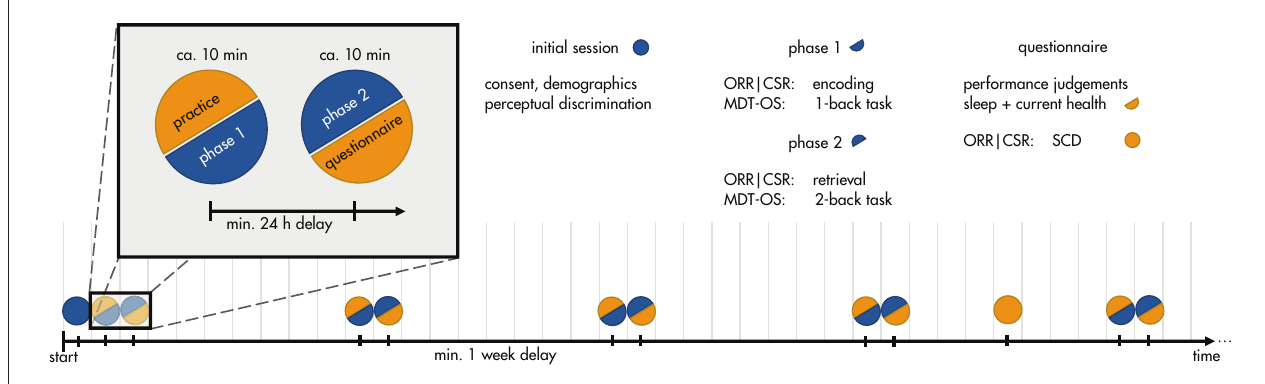
FIGURE 1 | Timeline of the study protocol. Participants enlisted for a 12-week study of weekly memory assessments. In a between-subjects design, participants were assigned to one of three tasks: Mnemonic Discrimination Test for Objects and Scenes (MDT-OS), Objects-in-Room-Recall (ORR), or Complex Scene Recognition (CSR). In the initial session, they gave consent, demographic information, and did a brief perceptual discrimination task. Each week, they received a short training session, followed by phase 1 of their respective task: encoding for ORR and CSR, and 1-back task for MDT-OS. 24h after finishing phase 1, they were notified that the next phase was available, and could perform it straightaway or postpone if inconvenient; that is, there was a minimum delay of 24h, but it was often extended by the participants (see Important Factors for Unsupervised Assessments). Phase 2 consisted of retrieval for ORR and CSR, and 2-back task for MDT-OS. It was followed by judgements regarding concentration and distraction throughout the task, current health (cold symptoms) and sleep quality. In week 4, participants of ORR and CSR received an additional questionnaire about subjective cognitive complaints (SCD).